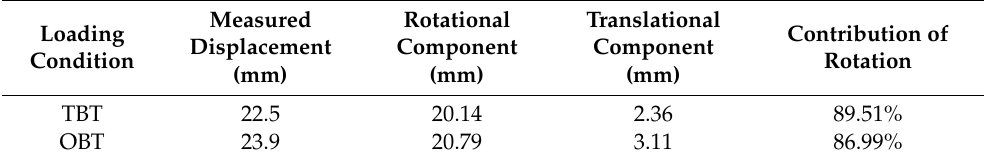
Table 4. Sharing of rotational component and translational component in measured structure displacement.